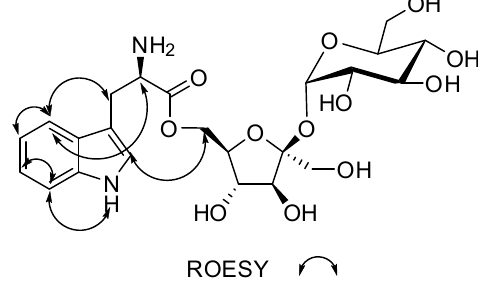
Figure 4 . Key ROESY (double arrow) correlations for compound 1 . Table 1. 1D and 2D-NMR spectroscopic data for compound ( 1 ) in DMSO- d 6 , in ppm.